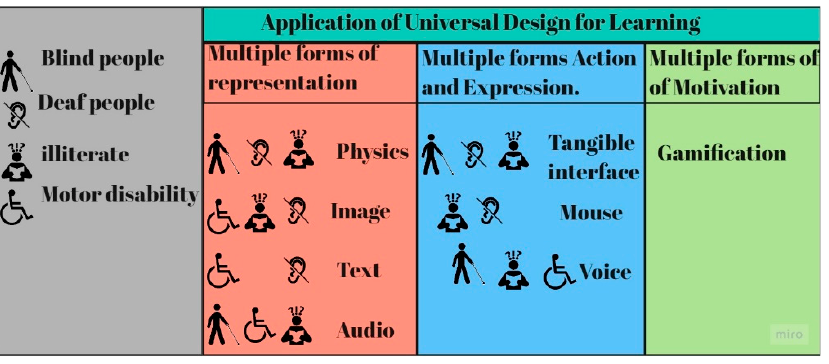
Figure 12. Indirect benefits of using universal design for learning.